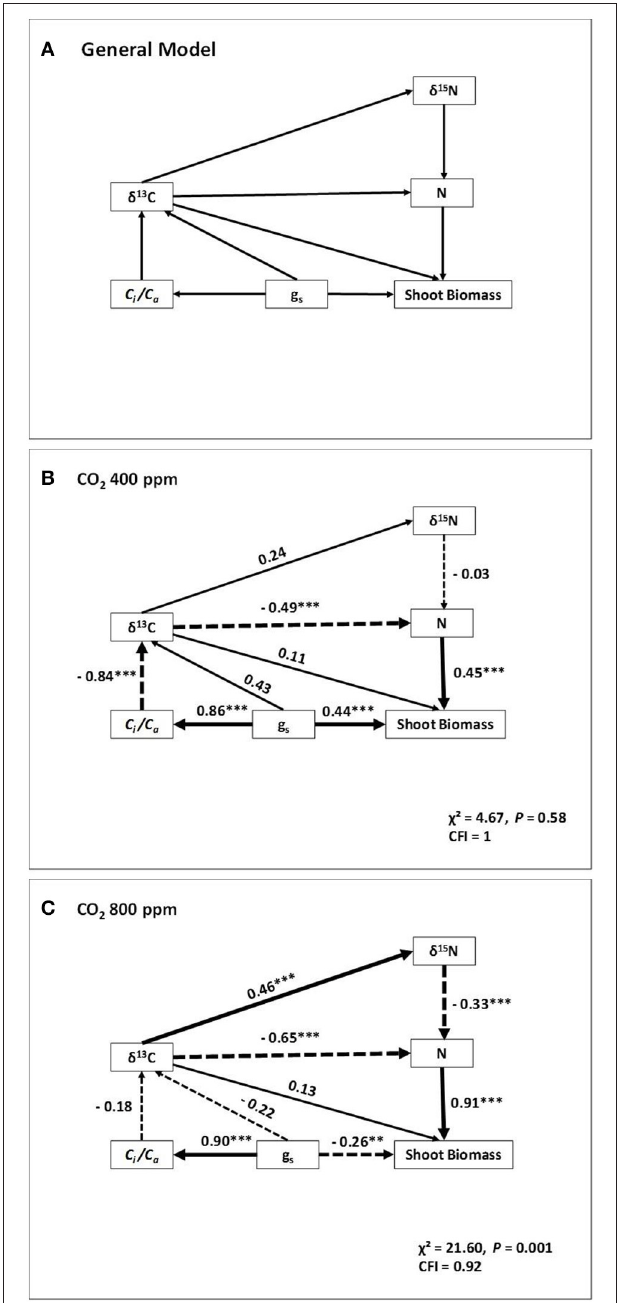
FIGURE 4 | Path analyses of four sweet pepper varieties grown under different water regimes and two [CO 2 ]. The conceptual model quantifying the relative strengths of direct and indirect relationships of gas exchange, stable isotope compositions and nitrogen concentration on shoot biomass (SB) is shown in (A) . Physiological parameters included in the model are: g s , stomatal conductance; C i /C a , the ratio of the intercellular vs. the atmospheric [CO 2 ]; δ 13 C, carbon isotope composition; δ 15 N, nitrogen isotope composition and N concentration of leaves. The width of arrows is proportional to the path coefficient values. Dashed lines indicate negative relationships. Overall fit statistics for each path model (x 2 and comparative fit index, CFI), the latter useful for small sample sizes (with values > 0.9 taken as indicative of a good fit), are shown at the bottom right of each panel. ** P < 0.01, *** P <